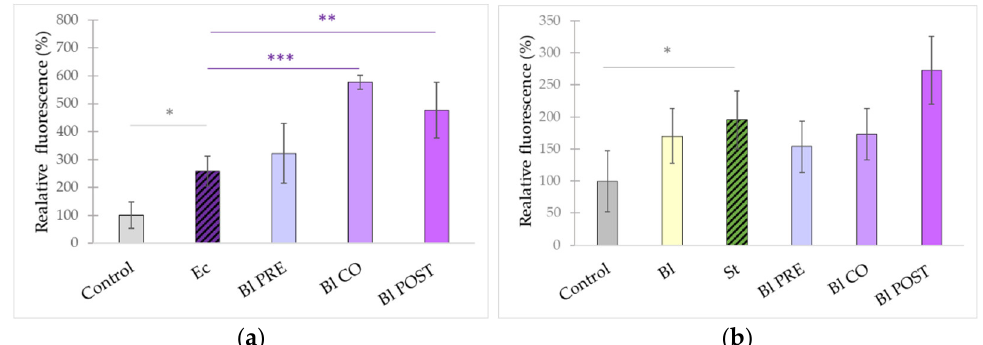
Figure 2. Effect of B. licheniformis on the paracellular permeability of IPEC-J2 cells treated with E. coli ( a ) and S. Typhimurium ( b ), respectively. B. licheniformis was added 1 h before (pre-treatment), at the same time as (co-treatment), and 1 h after (post-treatment) the addition of S. Typhimurium or E. coli , respectively. Detection of the FD4 dye was performed 24 h after the treatment of S. Typhimurium or E. coli, respectively. Control : plain cell culture medium treatment; Ec : E. coli 10 6 CFU/mL; St: S. Typhimurium 10 6 CFU/mL; Bl : treatment with B. licheniformis 10 8 CFU/mL; Bl PRE : pre-treatment with B. licheniformis 10 8 CFU/mL + E. coli 10 6 or S. Typhimurium CFU/mL; Bl CO : co-treatment with B. licheniformis 10 8 CFU/mL + E. coli or S. Typhimurium 10 6 CFU/mL; Bl POST : post-treatment with B. licheniformis 10 8 CFU/mL + E. coli or S. Typhimurium 10 6 CFU/mL. Data are shown as means with standard deviations and expressed as relative fluorescence, considering the mean value of control as 100%. n = 6/group. Significant difference: * p ≤ 0.05; in grey: compared with the untreated control. ** p ≤ 0.01; *** p ≤ 0.0001, in purple: compared with treatment with E. coli . Treatment with B. subtilis alone caused an increase in paracellular permeability com- pared with the control (Figure 3b). Pre-, co-, and post-treatments further increased the fluorescence signal measured in the basolateral compartment compared with the fluores- cence intensity increase induced by pathogens (Figure 3a,b).